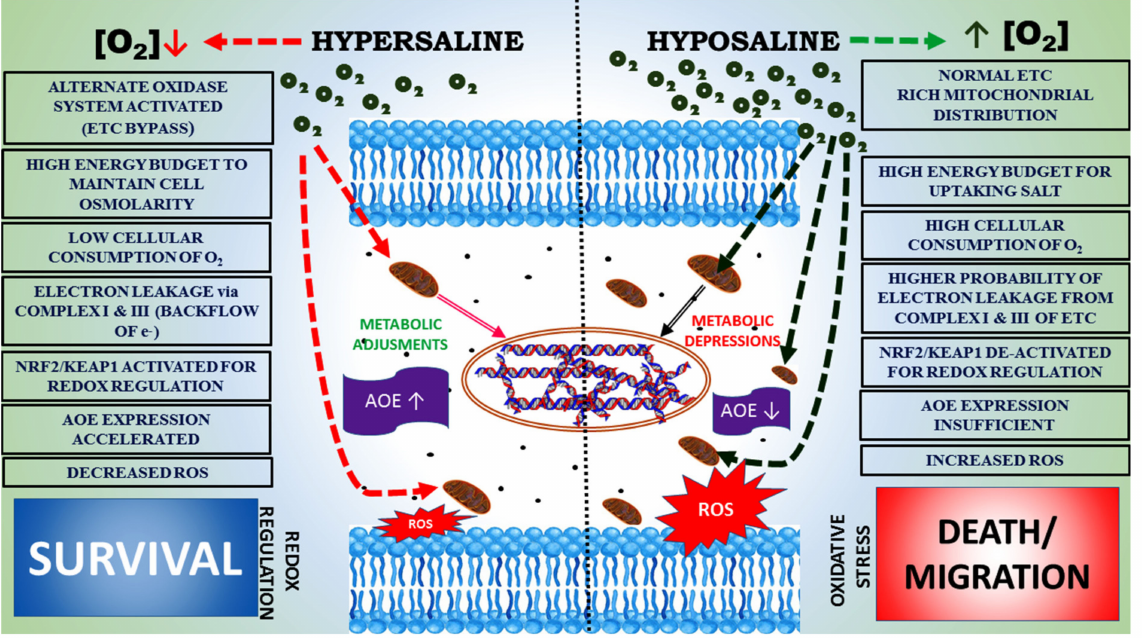
Figure 4. Responses of mitochondria to the changing salinity in relation to hypoxia or hyperoxia: Hy- posalinity with hyperoxia can modulate mitochondrial respiration, which can lead to the